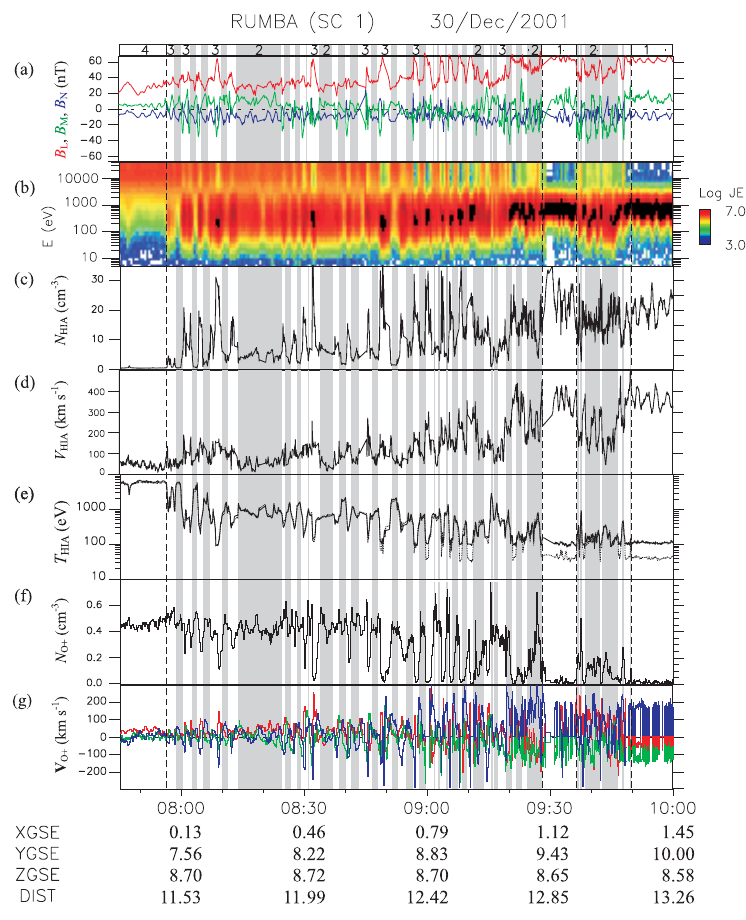
Fig. 8. Measurements in the MSP/MP/MSH from Cluster SC1 on 30 December 2001. The format is the same as in Fig.